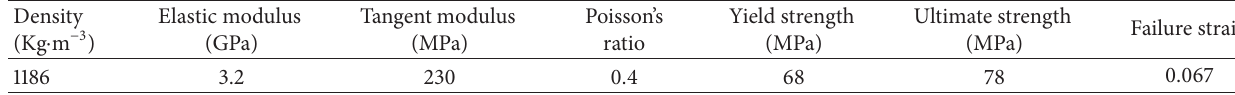
Table 1: Material properties of